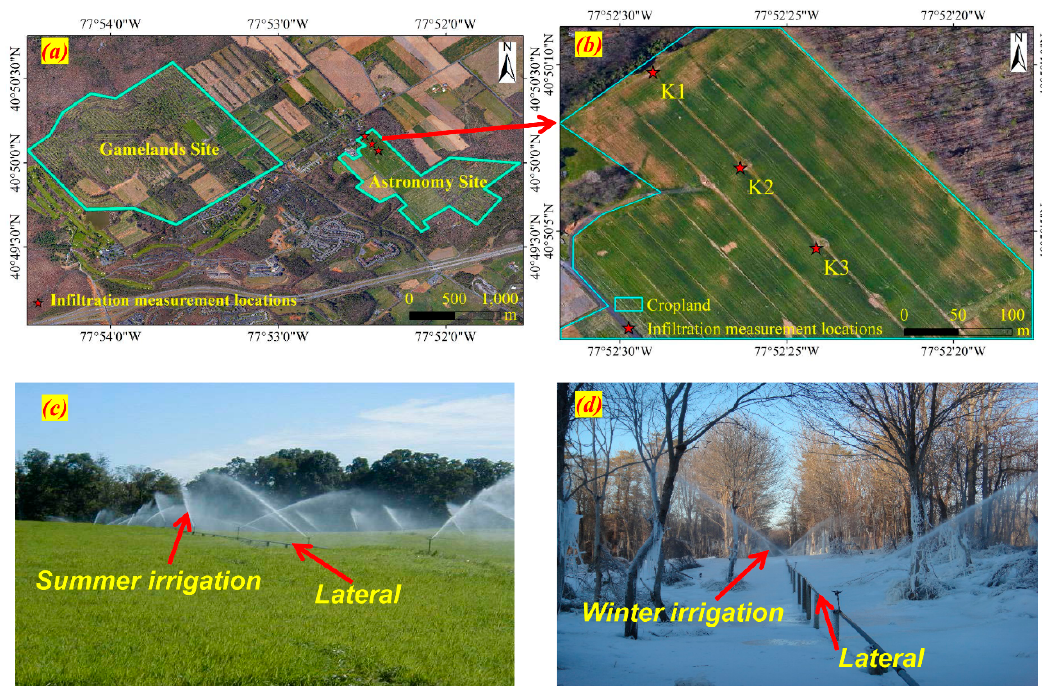
Figure 1. Penn State’s “living filter,” located in central Pennsylvania ( a ), with two fields—one is the State Game Land site (425 acres), and the other is the Astronomy site (182 acres); altogether, there are ~66% forested and ~34% cropped lands. The zoomed-in map ( b ) shows the cropped portion of the Astronomy site and indicates the infiltration measurement locations (K1, K2, and K3). Also included are photos demonstrating the operation of the living filter during the ( c ) summer and ( d ) winter.